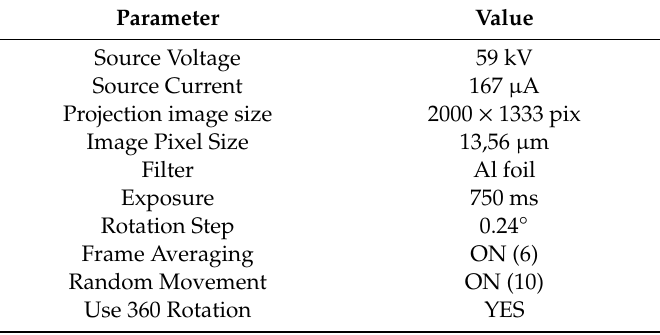
Table 4. Scanning Table 4. Scanning parameters.